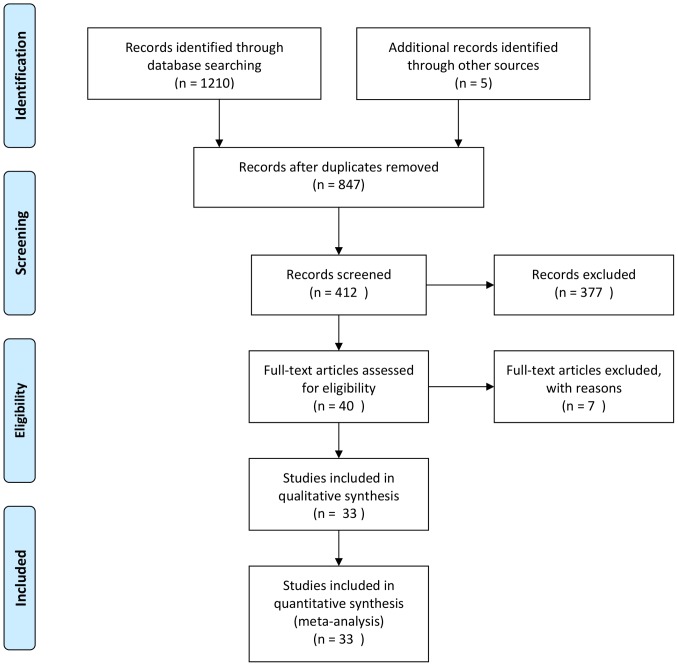
Flow of article selection.